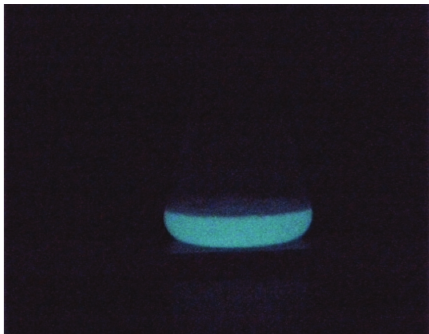
Figure 10: The bacterial cultures produced luminescence in dark condition when grown in luminescence broth for 12 hours at room temperature (27 ∘